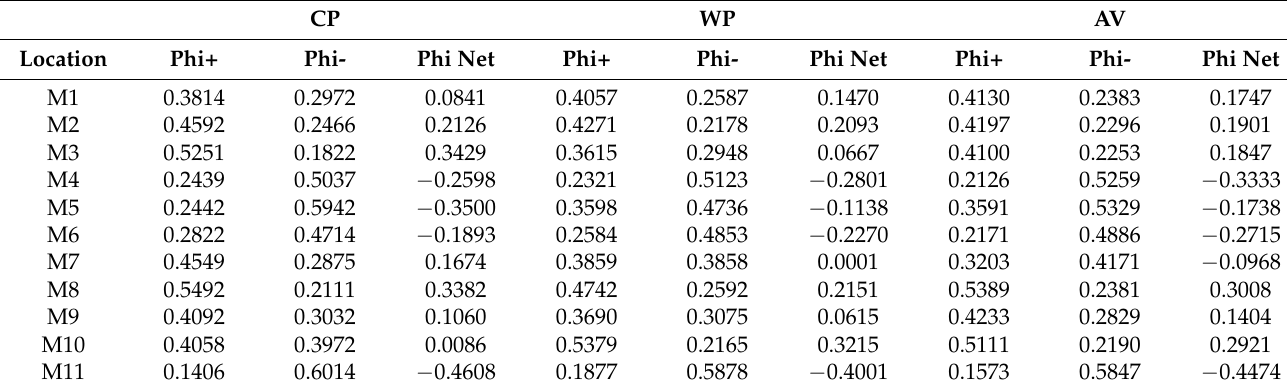
Table 2. Preference